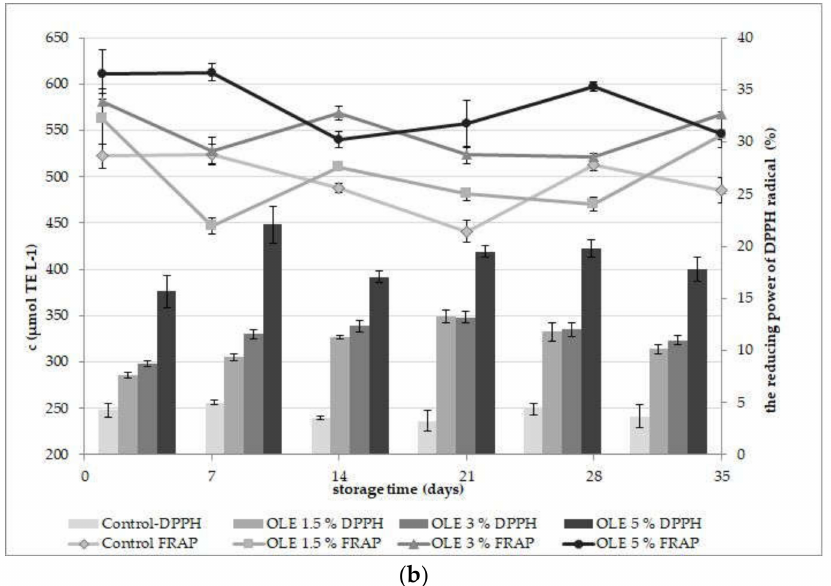
Figure 3. ( a ) The concentration of total phenols (c) expressed in mg of gallic acid equivalents (mg GAE L − 1 ) in yogurt samples without (control) and with olive leaf extract addition (OLE 1.5%, OLE 3%, and OLE 5%) during 35 days of cold storage; ( b ) antioxidant activity measured by the DPPH assay expressed as the reducing power of DPPH radical (%) and the FRAP assay expressed as the concentration (c) of Trolox equivalents ( µ mol TE L − 1 ) in yoghurt samples without (control) and with olive leaf extract addition (OLE 1.5%, OLE 3%, and OLE 5%) during 35 days of cold